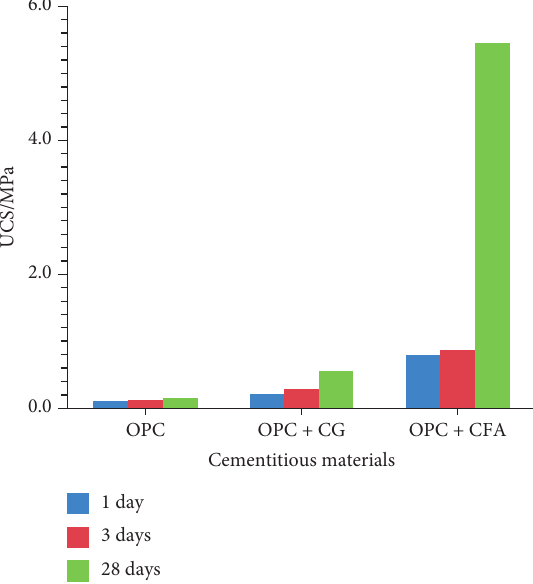
Figure 11: The results of UCS of CPB adding different cementi- tious